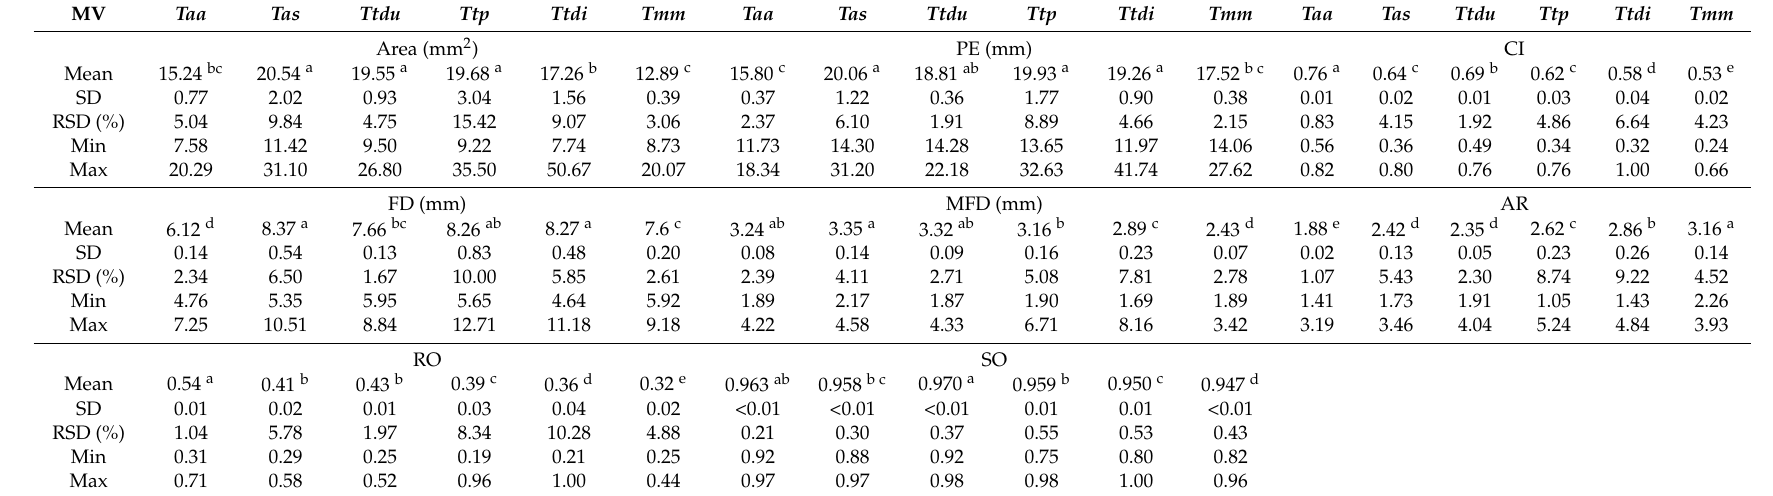
Table 3. The values of shape descriptors taken into consideration in the kernel image analysis of wheat